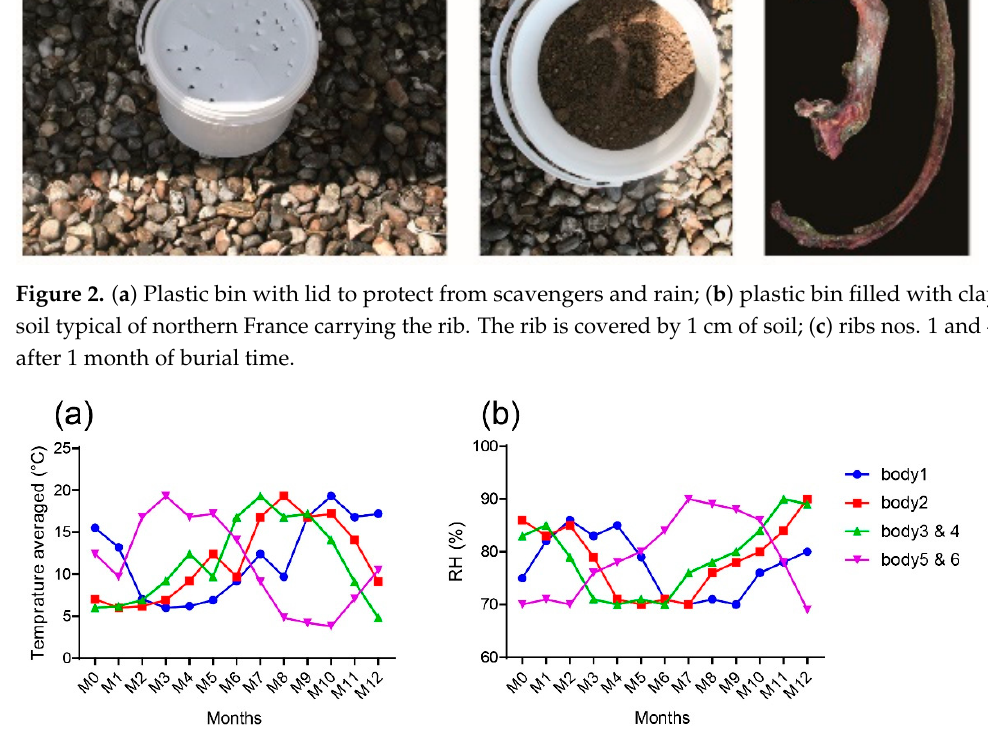
Figure 3. ( a ) Averaged outdoor temperature (°C) per month during 12 months for each body. ( b ) Averaged RH (%) during the 12 months for each body. The month M0 is different depending on the body. For body 1, M0 = September 2013; body 2, M0 = November 2013; bodies 3 and 4, M0 = December 2013; bodies 5 and 6, M0 = April 2014.